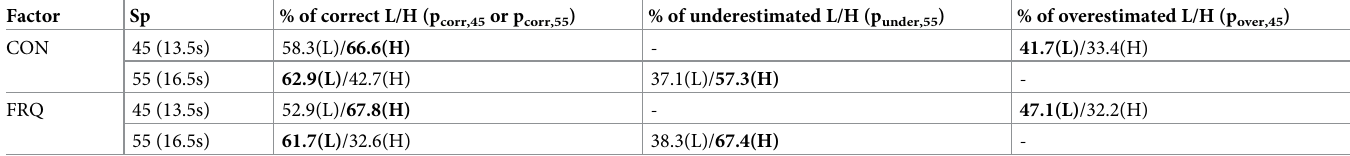
Table 3. A) Results of the follow-up replication study with conventional displays. Accuracy (% of correct answers) is higher for high magnitude levels of contrast and frequency at 45% sp (“less than half” answers), while at 55% (“more than half” answers) it is always higher for low magnitude levels of contrast and frequency. At 45% sp, overestimation (incorrect responses, “more than half” answers) occurs more frequently for low magnitude levels. At 55% sp, underestimation (incorrect responses, “less than half” answers) occurs more frequently at high magnitude